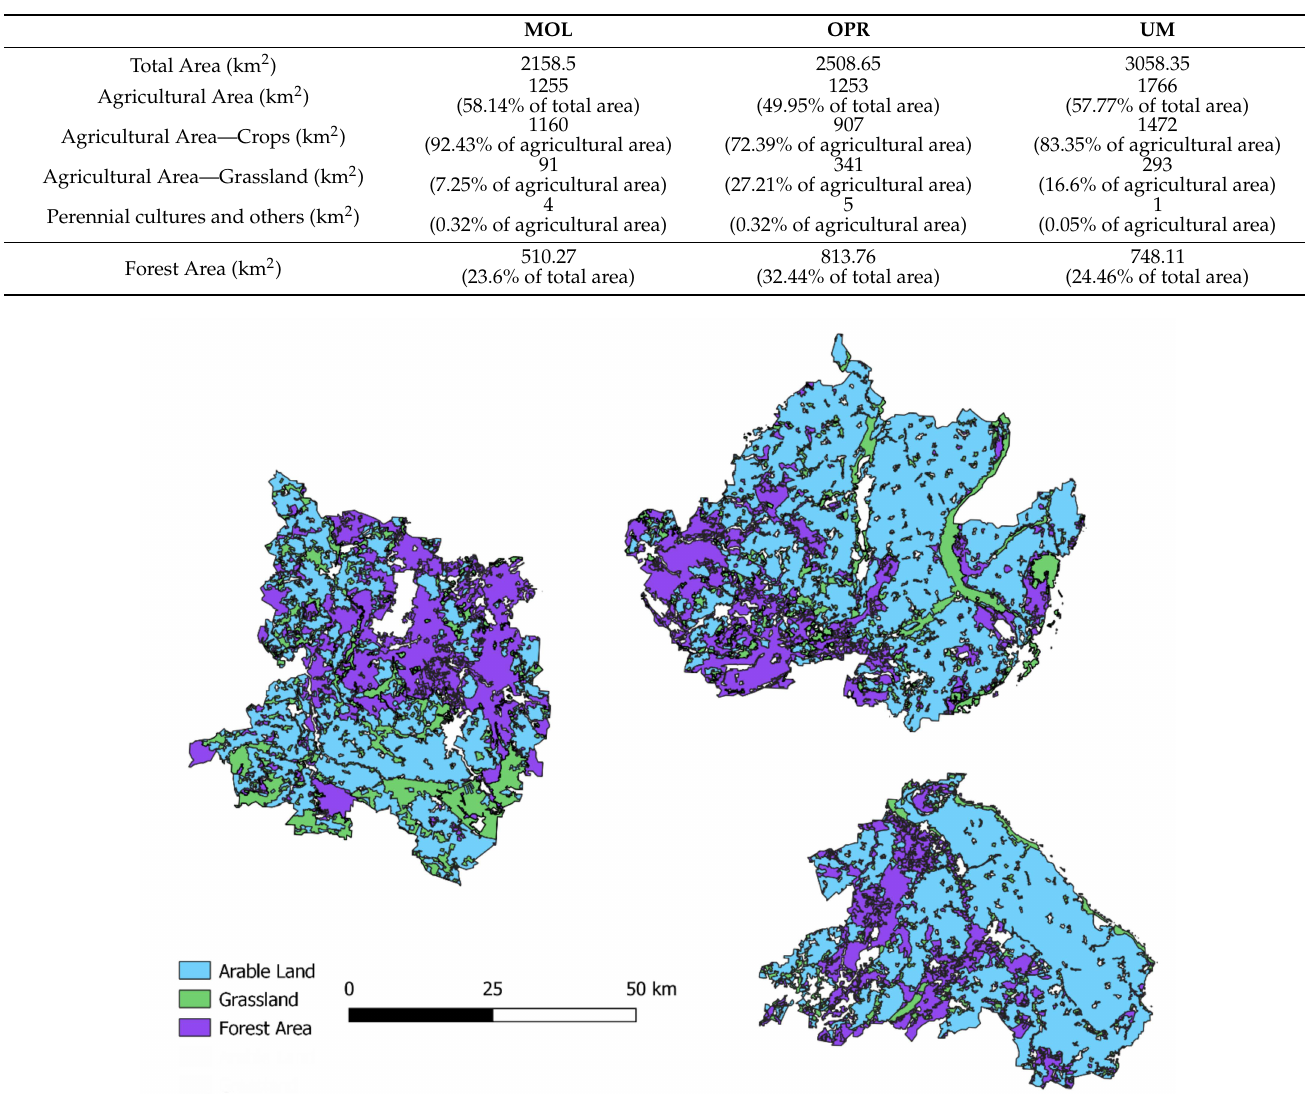
Table 2. Land use in all case study areas, 2019 (MOL = Märkisch-Oderland; OPR = Ostprignitz-Ruppin; UM = Uckermark) [27].